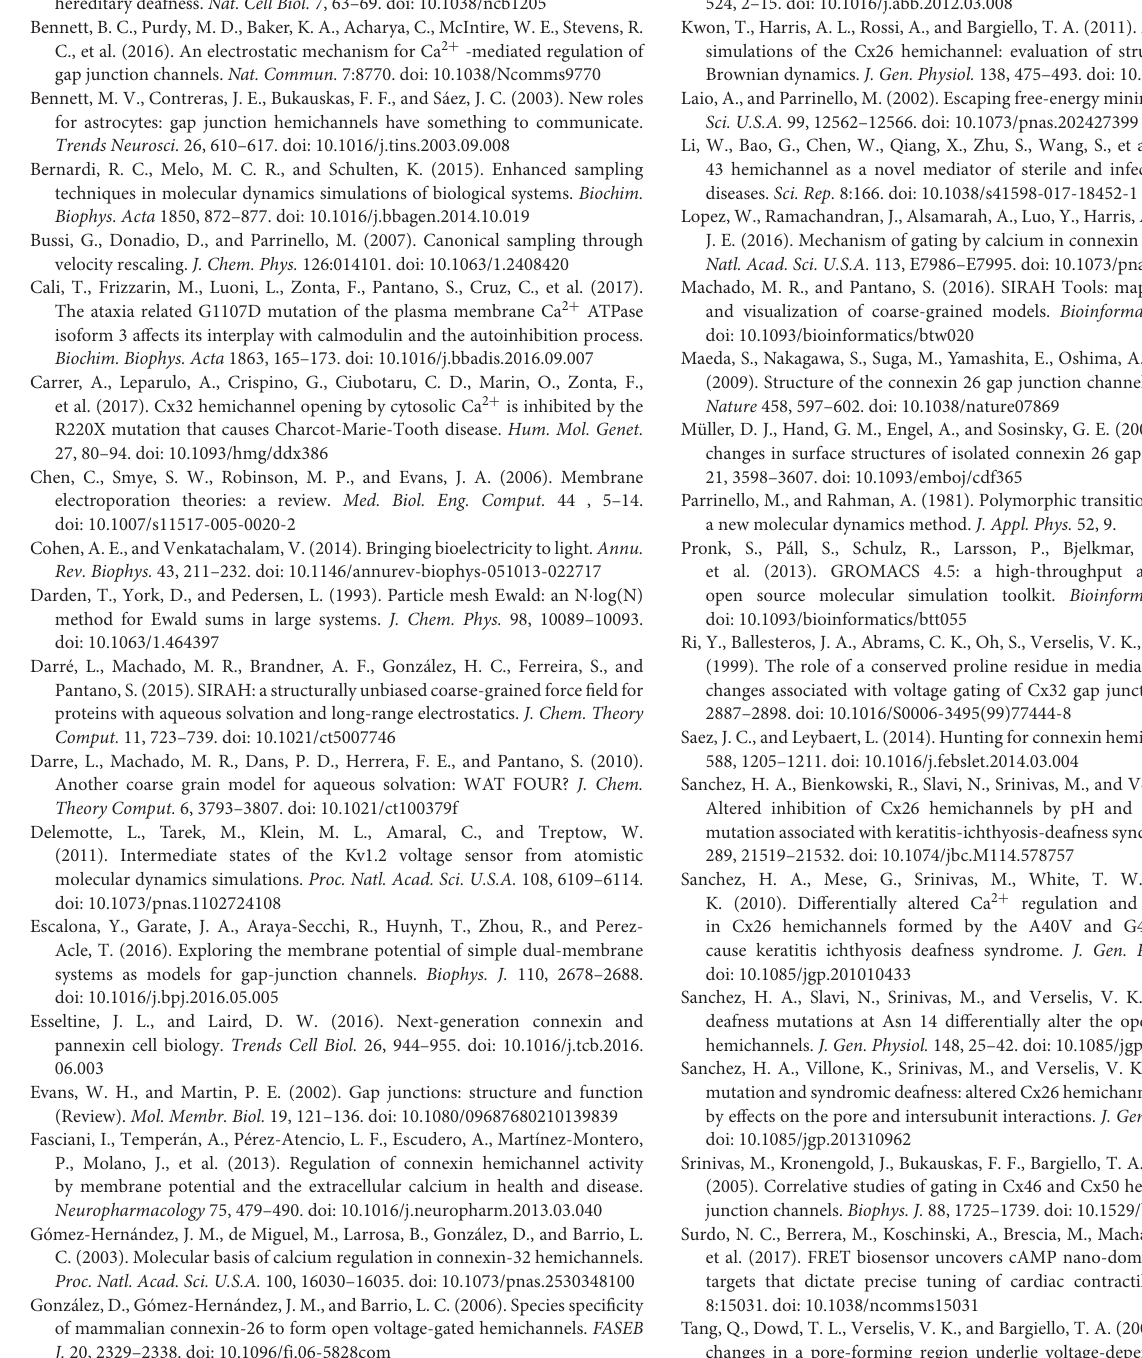
8:15031. doi: 10.1038/ncomms15031 Tang, Q., Dowd, T. L., Verselis, V. K., and Bargiello, T. A. (2009). Conformational changes in a pore-forming region underlie voltage-dependent “loop gating”